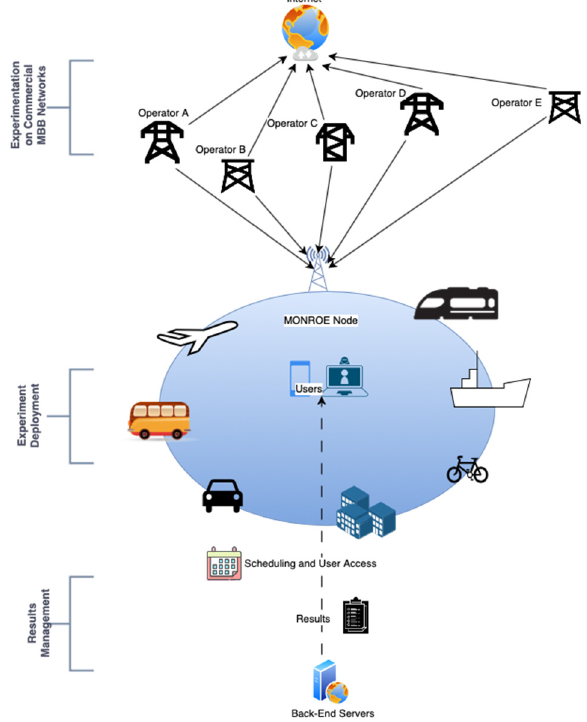
Figure 9. Overview of the MONROE platform.